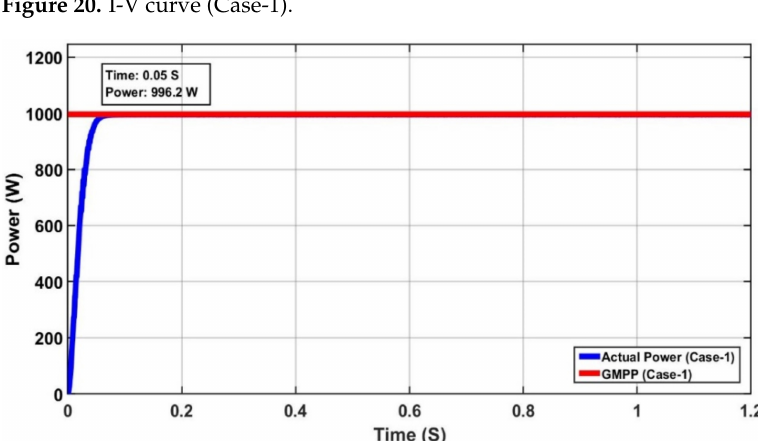
Figure 20. I-V curve (Case-1).